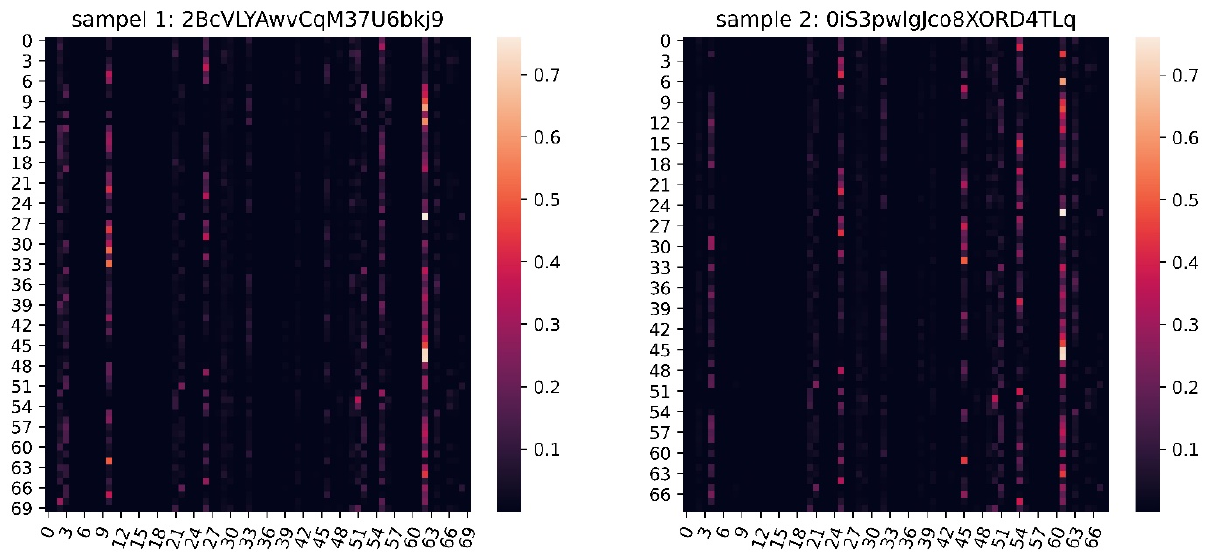
Figure 10. Visualization of triangular attention on two random malware samples.